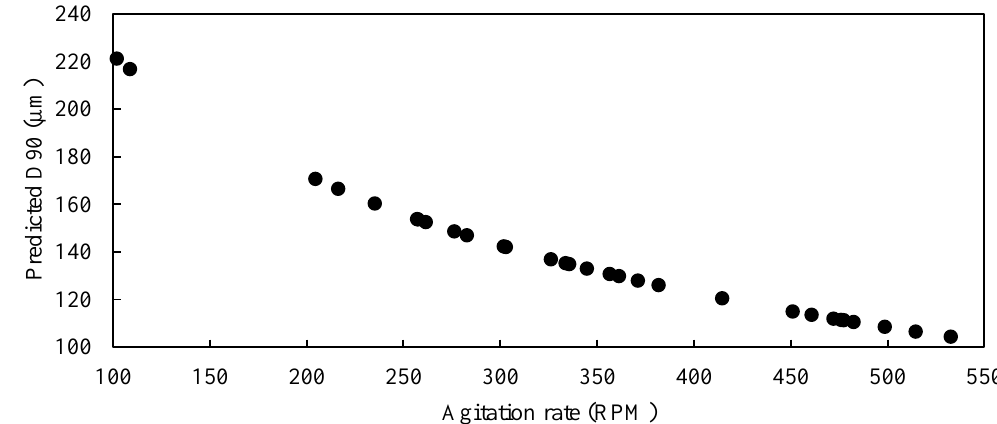
Figure 5. Predictions of D90 of final material as a function of agitation rate in a 250 mL Chemglass reactor, for the crystallization process of BMS compound A, generated via population balance modeling (PBM).